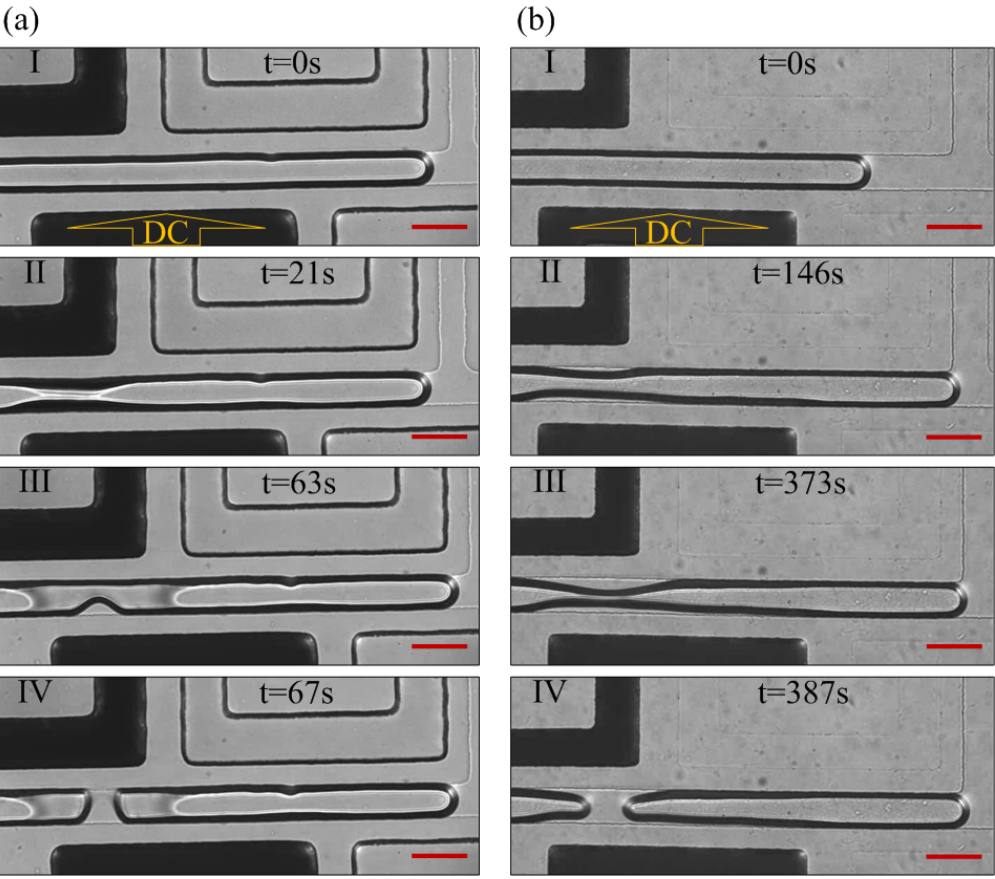
Figure 2. The droplet generation process under 2600 V voltage. ( a ) Droplet generation process in scheme 1; ( b ) droplet generation process in scheme 2. Voltage was applied on the electrode marked as “DC” (Channel 5). The scale bars are 100 μm.